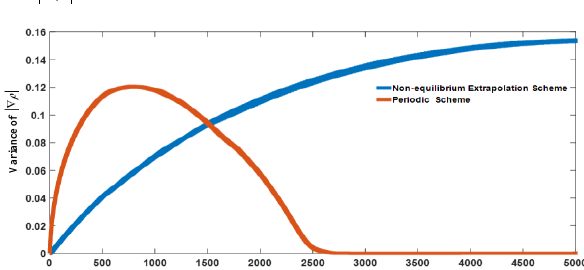
Fig. 4. Mean value of  over iterations.